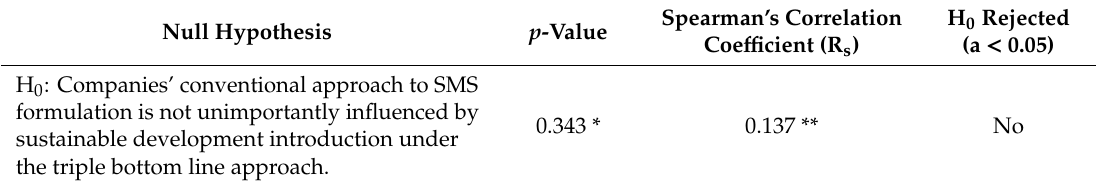
Table 3. Hypothesis 2 Testing: Spearman’s correlation